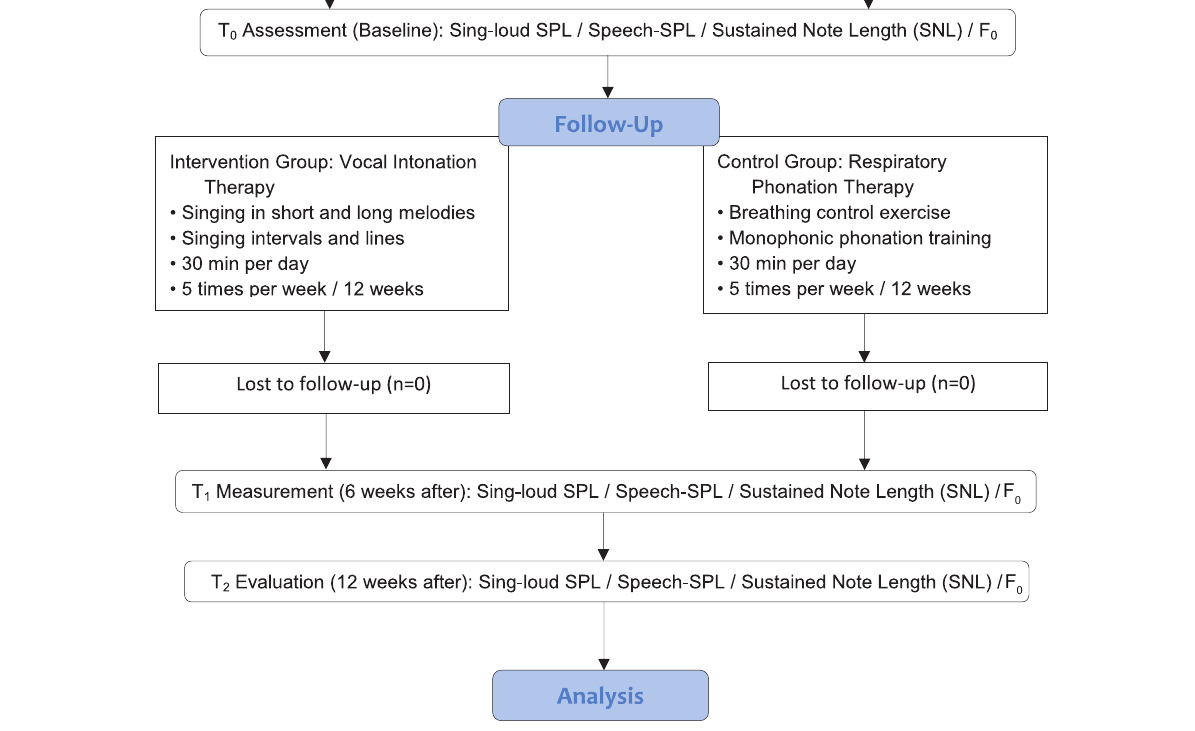
FIGURE 1 | Flow diagram, consort flowchart for participants’ recruitment and